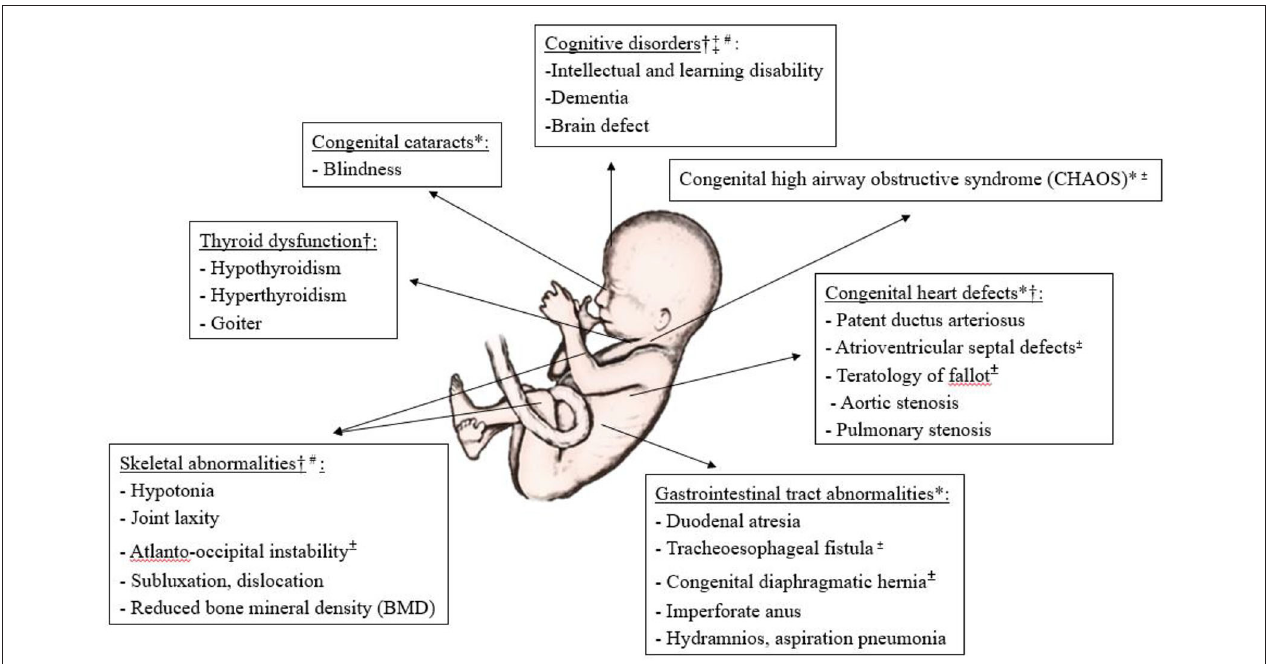
FIGURE 2 | Illustration of common developmental anomalies and degenerative deficits in Down’s syndrome, and the potential for prenatal and postnatal interventions. *Potential for prenatal surgical therapy, † Potential for prenatal medical therapy, ‡ Potential for prenatal gene therapy, ± Risk to life in utero or immediately after birth, # Clinical trials available, Others if not indicated, mainly for postnatal intervention.